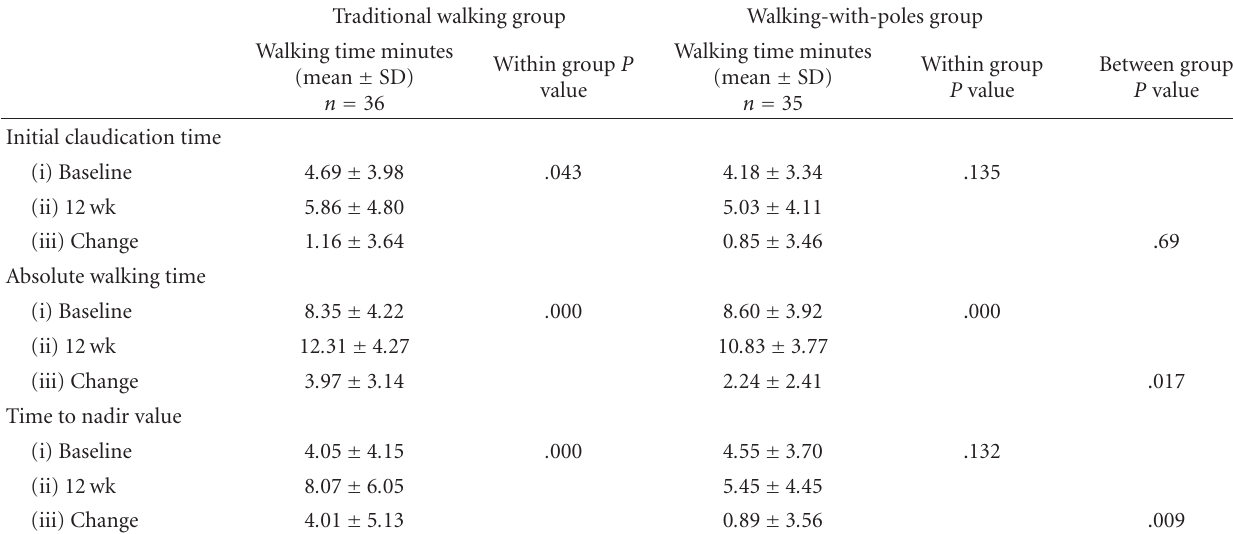
Table 4: Exercise times at baseline and 12 weeks for those who completed training ( n = 71). Traditional walking group Walking-with-poles